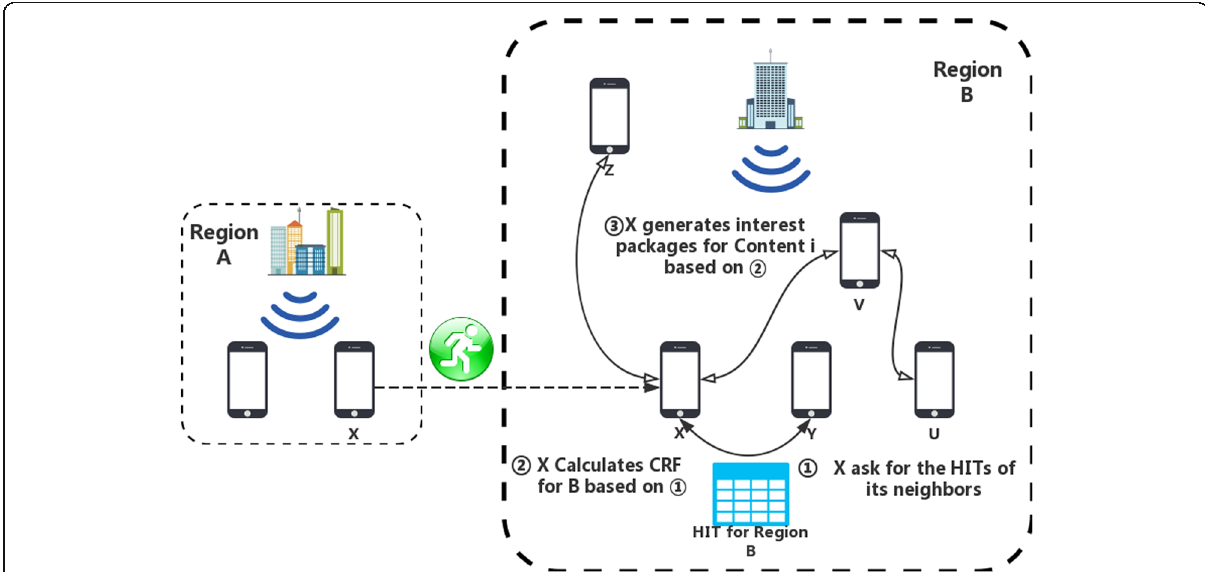
Fig. 1 Model overview of cache rebalancing. The cache rebalancing approach asks any node it meets for the HIT of region B, indicating the node can proactively obtain the user requirement patterns of the new region it enters, and add the new regions CRF to its own one to rebalance its caching